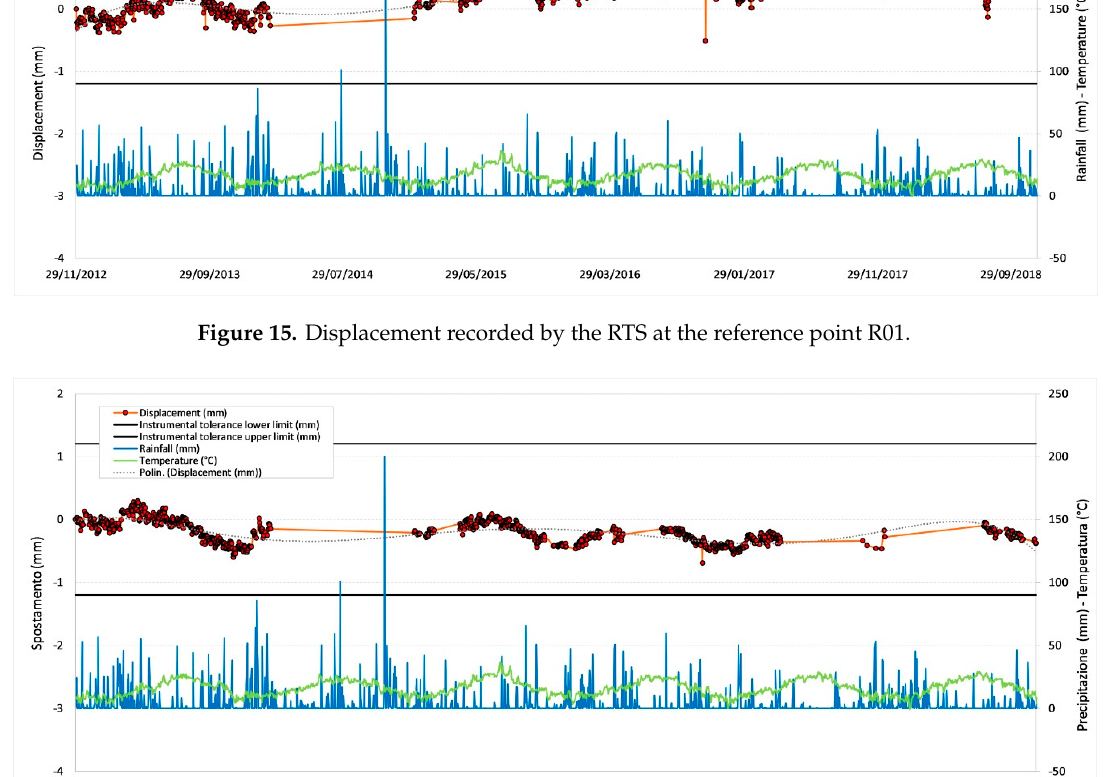
Figure 16. Displacement recorded by the RTS at the reference point R02.